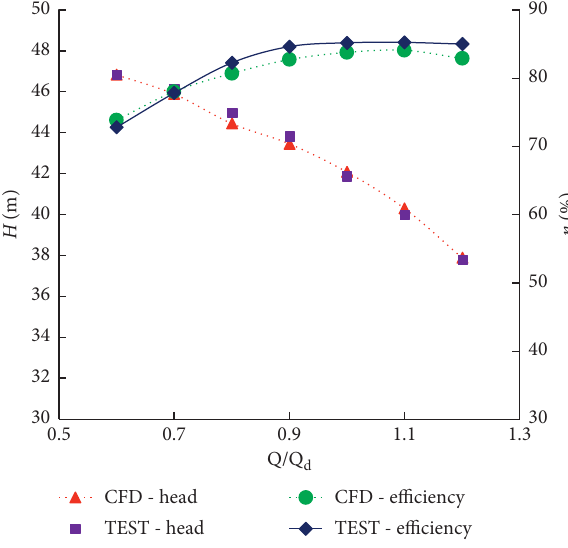
Figure 7: Validation with test